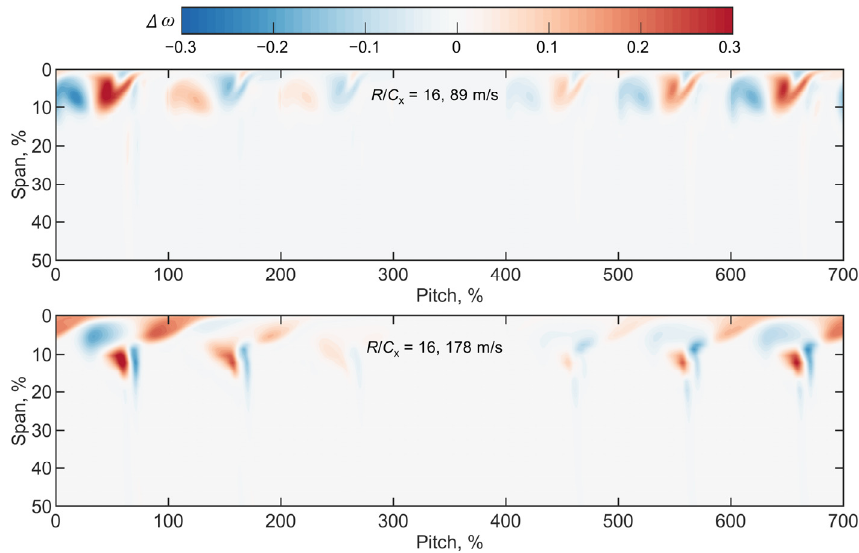
Figure 15. Total pressure loss coefficient difference at different pitch locations.